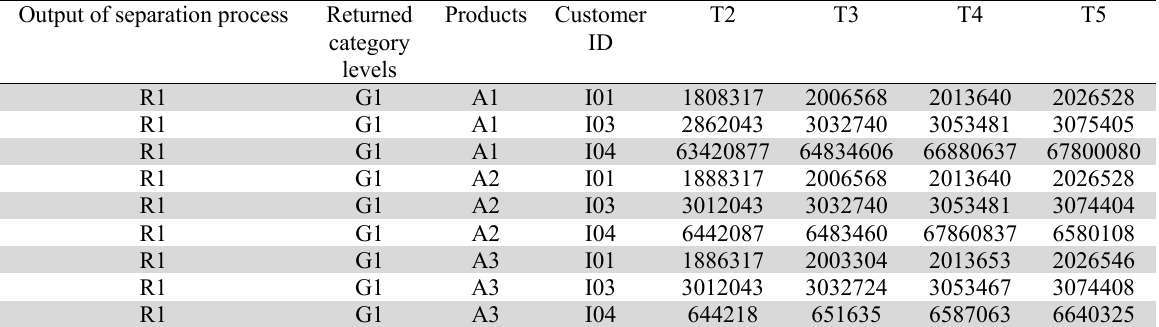
The number of customers' unsatisfied demand during periods T2-T5 Output of separation process Returned category levels